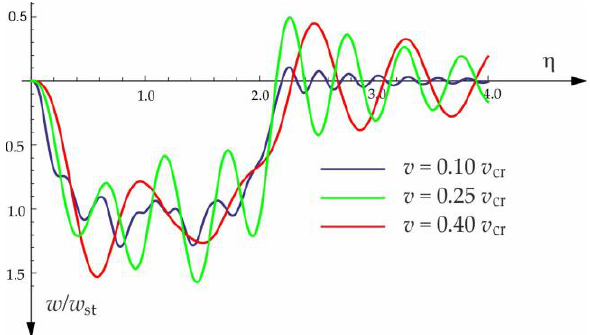
Figure 16. Influence of moving forces ’ velocity on deflection of midpoint of the beam on three-parameter Vlasov foundation subjected to the group of three forces moving at a distance of a = 3 m and a damping number of ξ = 0.05.